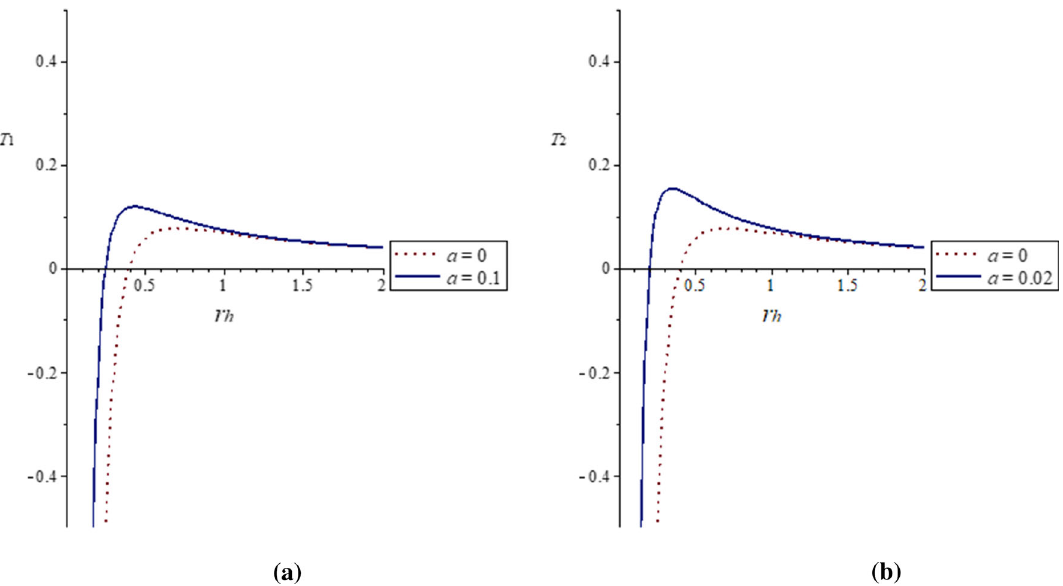
Fig. 1 The Hawking temperature versus the event horizon radius with q = 0 . 4, the dotted curve is the Reissner–Nordstrom case and the solid curve is the non-minimal